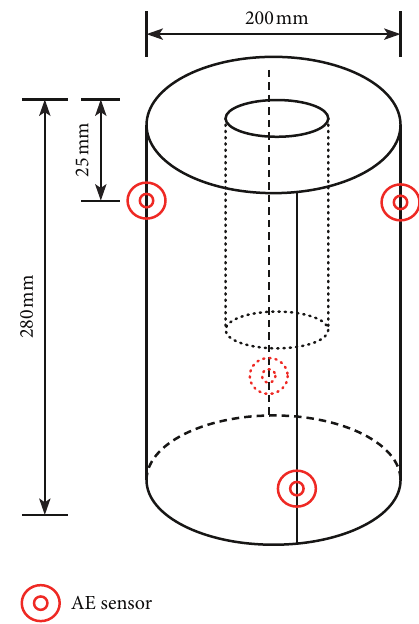
Figure 2: Sketch of the AE sensors